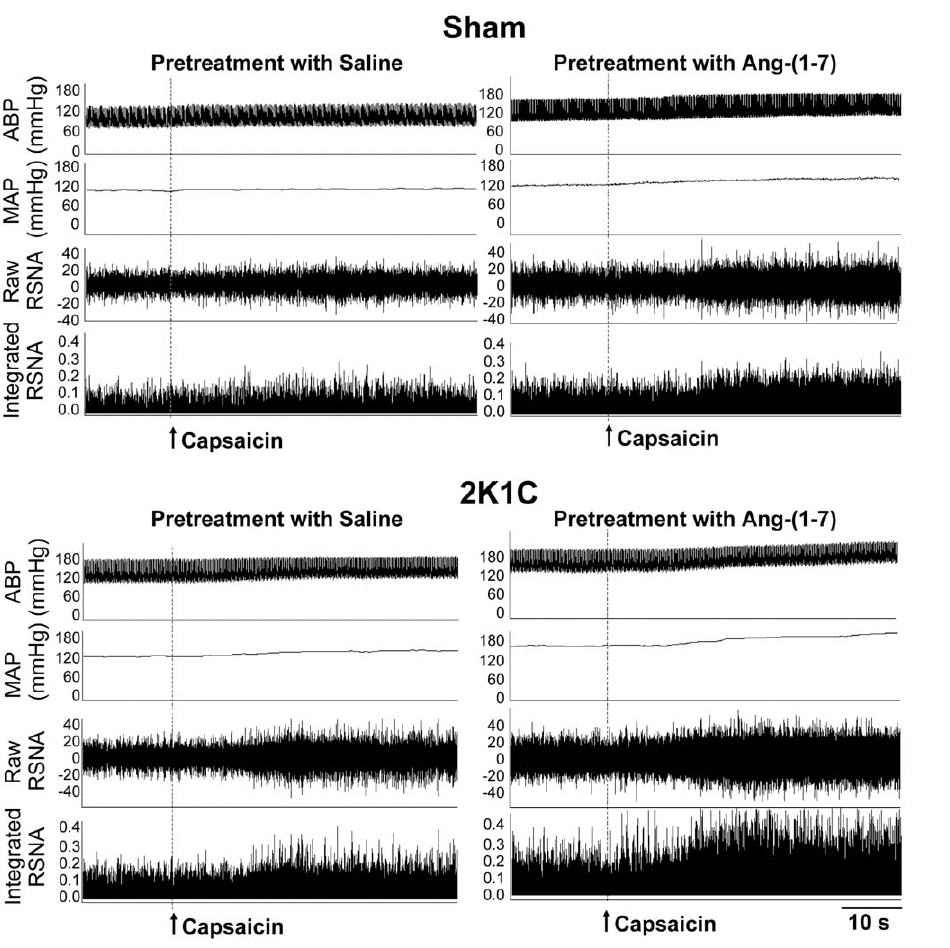
Figure 2. Representative recordings showing the effects of PVN microinjection of saline and Ang-(1–7) (3 nmol) on the CSAR in Sham and 2K1C rats. The CSAR was evaluated by the RSNA and MAP responses to epicardial application of capsaicin (1